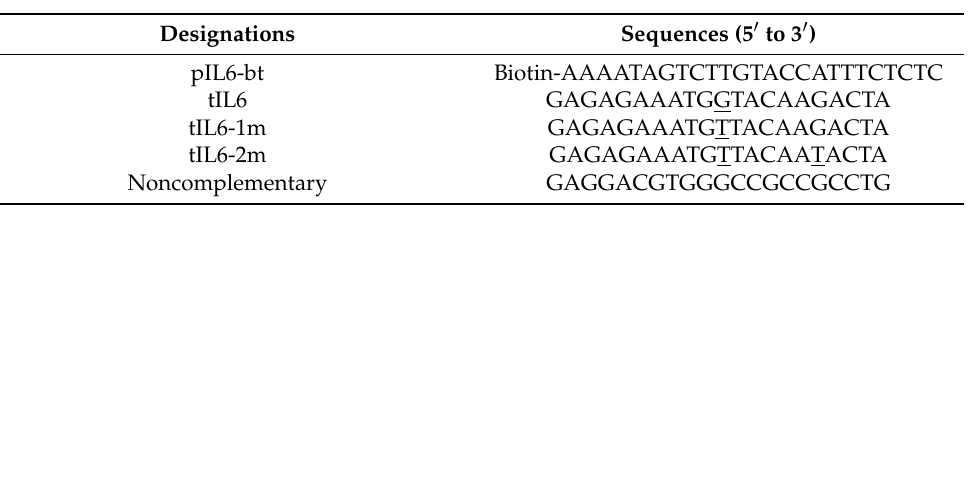
Table 1. Sequences of the DNA oligonucleotides used in this work. The point mutations are